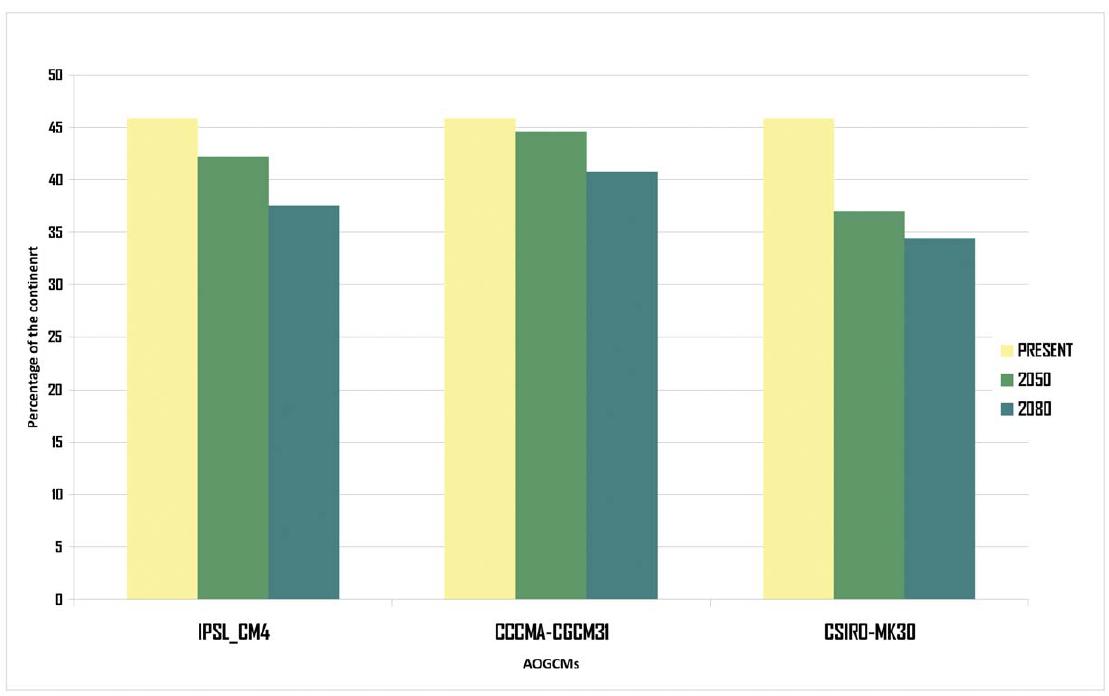
Figure 3. Histogram of suitable surface. Percentage of suitable surface of the entire continent for Lithobates catesbeianus at the three analyzed time slices and AOGCMs.